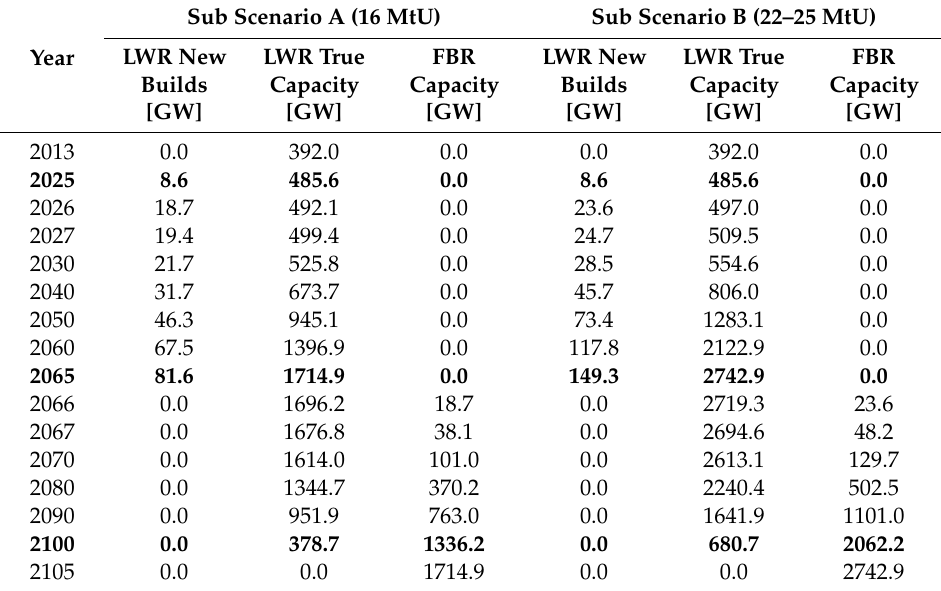
Table 1. Proposed dynamics of lightwater reactor (LWR) / fast breeder reactor (FBR) buildup for scenario